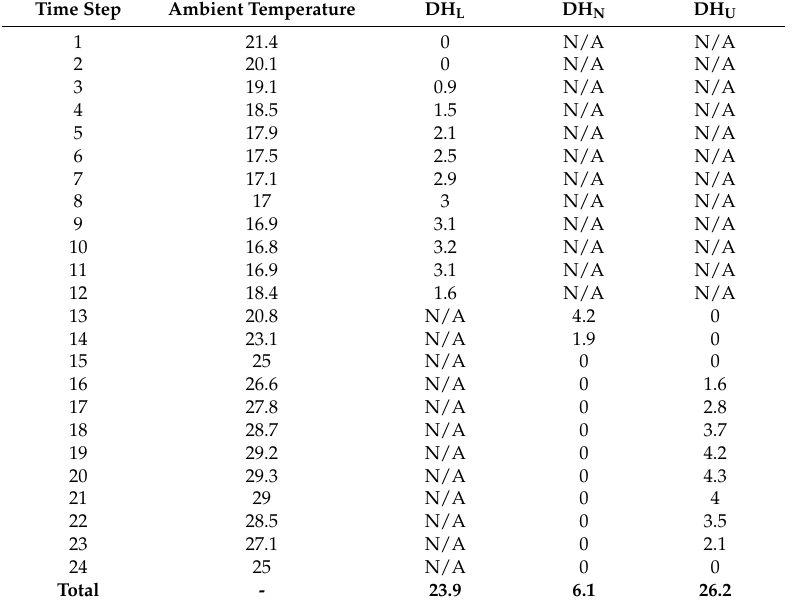
Table 3. Calculation of the DH values for each time step for the sample day. The summation of the values in the end represents the values of DH L , DH N , and DH U used in the precooling ratios. Time Step Ambient Temperature DH L DH N DH U 21.4